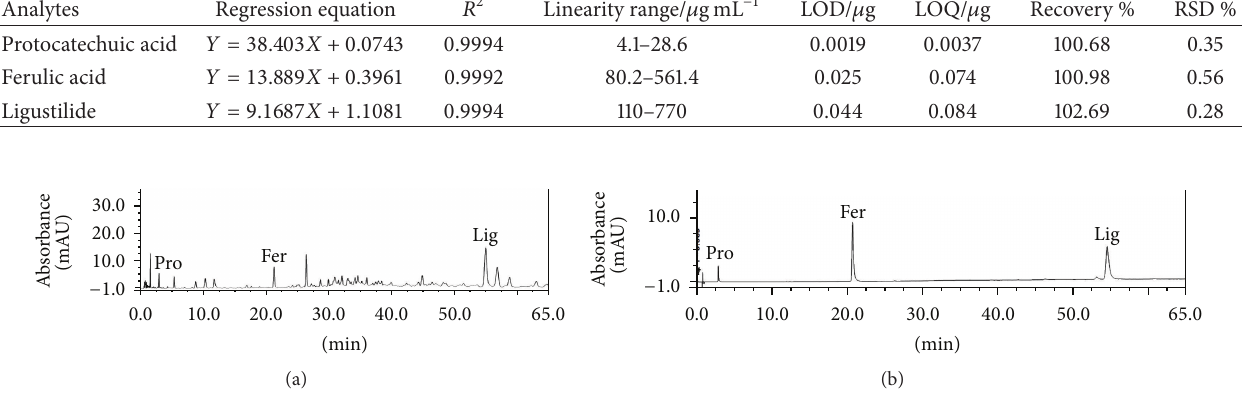
Figure 1: Representative HPLC chromatograms of mixed standards and the ZTP extract at 260 nm. (a) ZTP extract (sample 1209051H); (b) mixed standards of the 3 chemical constituents. Peaks: protocatechuic acid, ferulic acid, and